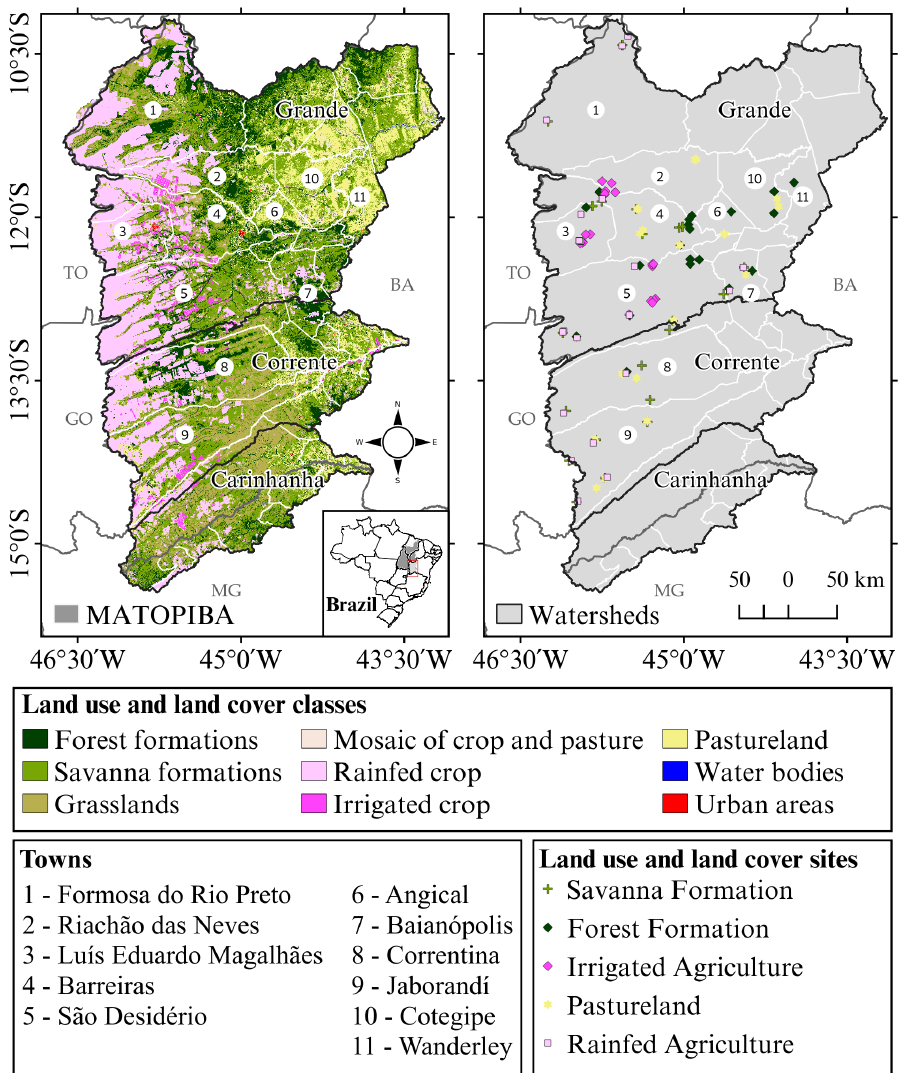
Fig 1. Study area and locations of the soil sample collection sites and main towns in the region. Symbol colors represent different land use and land cover classes. This figure was made using open source geographic information system (QGIS) and open data source: watersheds vector lines and the land use and land cover classification map were obtained from OBahia (http://obahia.dea.ufv.br), and geopolitical borders were obtained from IBGE (https://mapas.